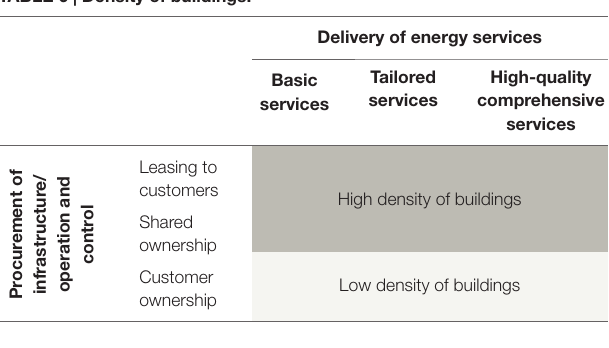
TaBle 7 | Buildings typology.